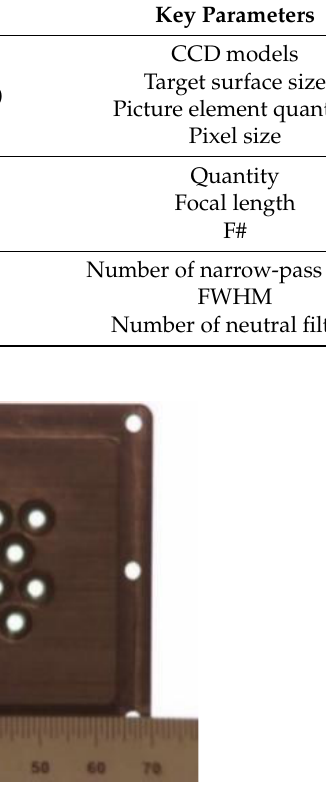
Figure 24. Photograph of a lens plate containing 18 lens assemblies in a hexagonally close-packed array.